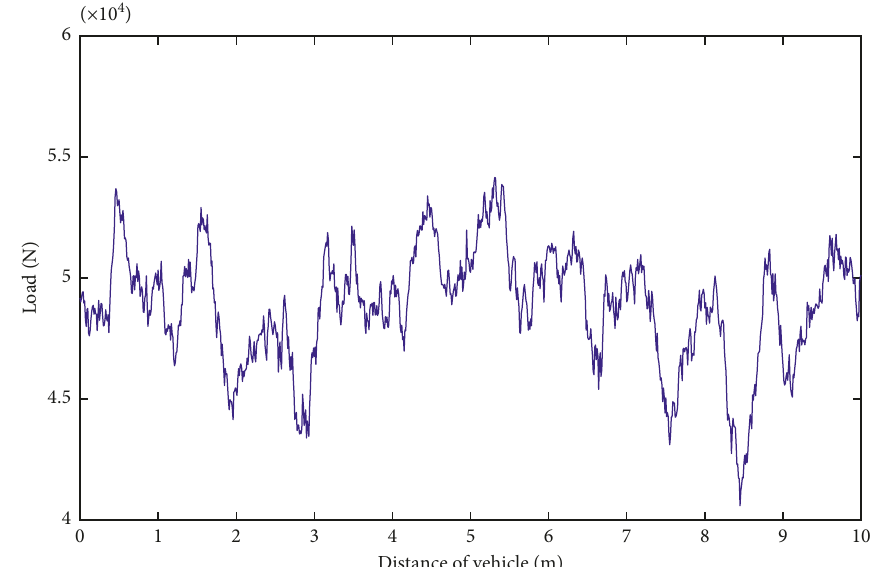
Figure 2: The random dynamic load when the vehicle speed is 10m/s and road is class A road.